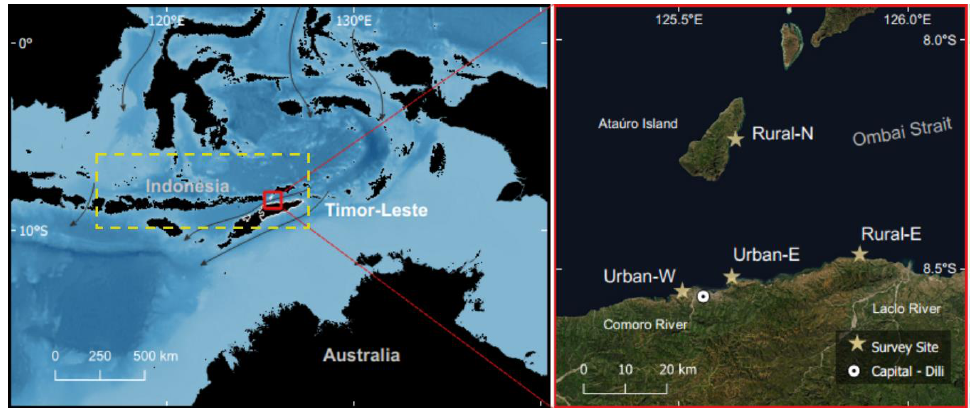
Figure 1. Timor-Leste lies between Indonesia and Australia within the Indonesian ThroughFlow (ITF). Arrows indicate inflows and outflows of the ITF adapted from [81,82]. The yellow dashed box indicates the Lesser Sunda Islands (adapted from [85]). Enlarged map on the right shows the location of the survey sites in Timor-Leste near the capital of Dili. Survey sites are Rural-N on Ataúro Island in the Ombai Strait, Rural-E 40 km east of Dili, and Urban-W and Urban-E flanking Dili. The highly seasonal Comoro River can be seen just east of Urban-W (in Dili) and the Laclo River east of Rural-E. The four sites were sampled on two occasions in November 2015 and June 2017. Jaco Island lies at the easternmost point of the country.